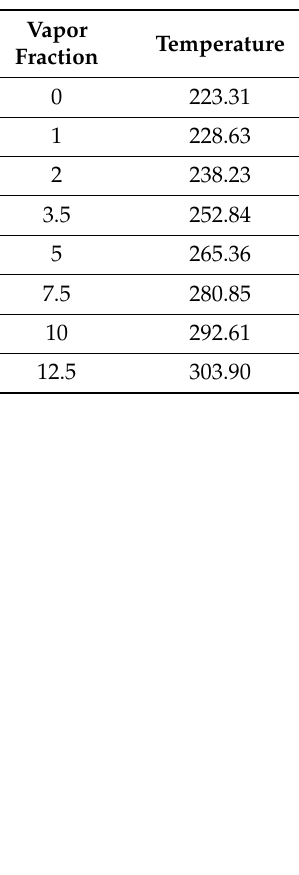
Table 11. Distillation curve of the initial mixture.